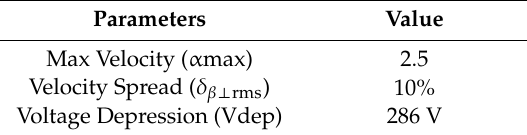
Table 4. Optimal electron beam parameters by theoretical calculation.